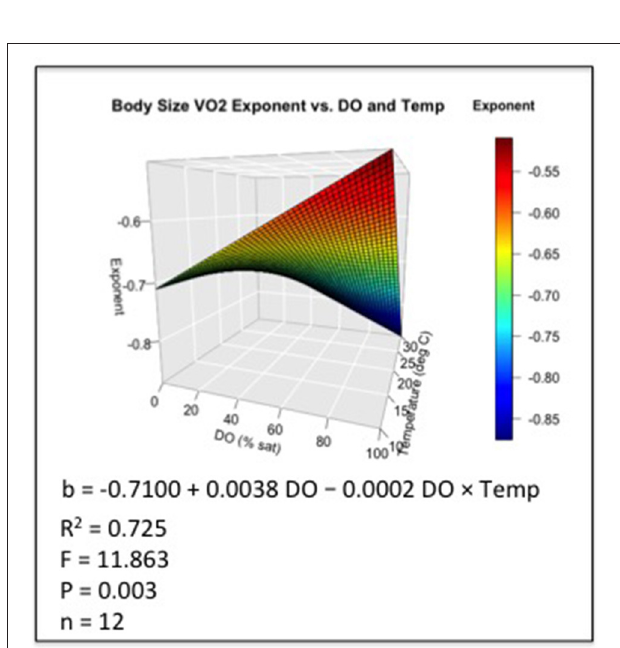
FIGURE 2 | Non-linear response surface fit to V O2 size-related exponent (b) relative to DO and temperature, including significant terms for a constant, DO saturation, and the DO × temperature interaction (see Table 1